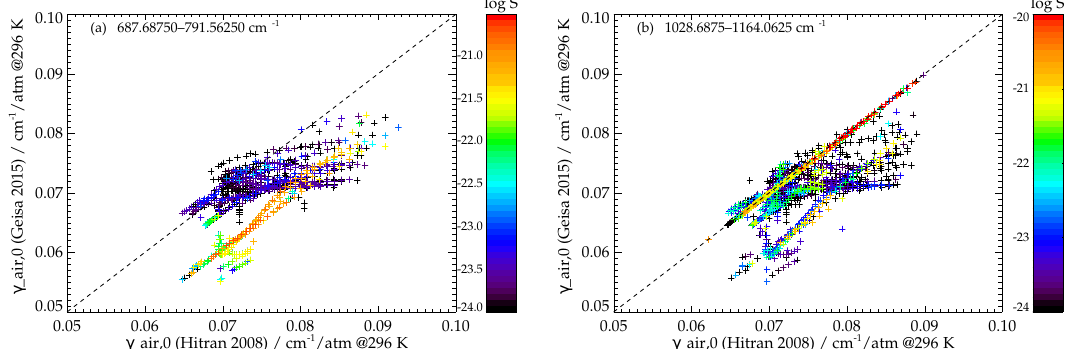
Figure 8. (a) Air-broadened half widths γ air , 0 of GEISA-2015 versus HITRAN-2008 for the microwindows in MIPAS channel A. (b) Same as on the left, but for the microwindows in channel AB. The half widths are colour-coded by the logarithm of the HITRAN-2008 line intensities.